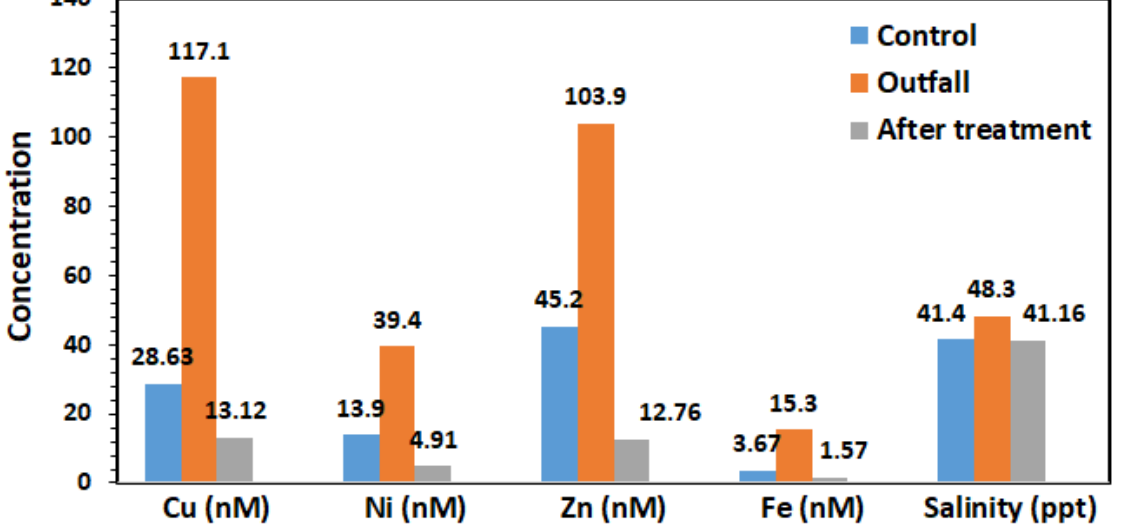
Figure 13. Comparison of metal ions and salinity concentrations of the desalination plant outfall brine discharge with the treatment by HS nanoclay before and after treatment. (Experimental conditions: 60.0 mL solution, 90 min adsorption time, 150 mg dosage, and pH 8.0, at 25 °C temperature).